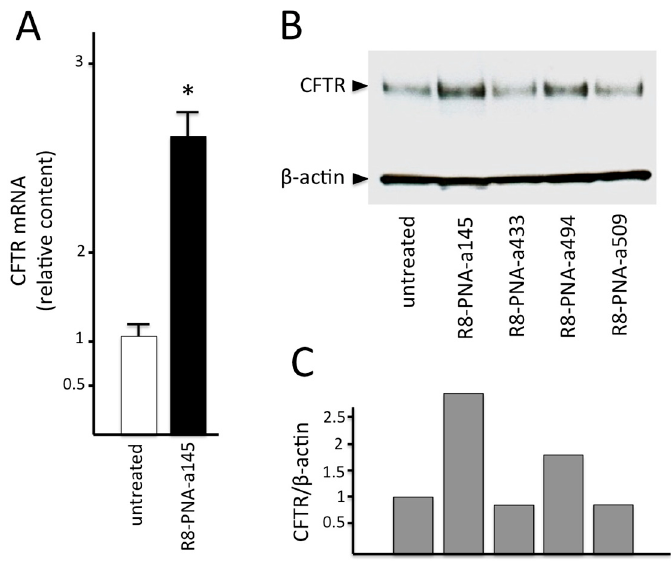
Figure 4. Upregulation of CFTR mRNA (RT-qPCR, ( A ); N = 3; * = p < 0.05) and CFTR protein (Western blotting, ( B , C )) in Calu-3 cells cultured for 72 h in the absence or in the presence of R8-PNA-a145-5p. CFTR and β -actin is indicated in panel ( B ) with arrowheads. Effects of PNAs targeting miR-433, miR-509-3p and miR-494 are also shown in panel ( B ). In panel ( C ) the quantitation of the CFTR/ β -actin ratios are shown and were obtained by densitometric analysis of the Western blotting shown in panel ( B ).